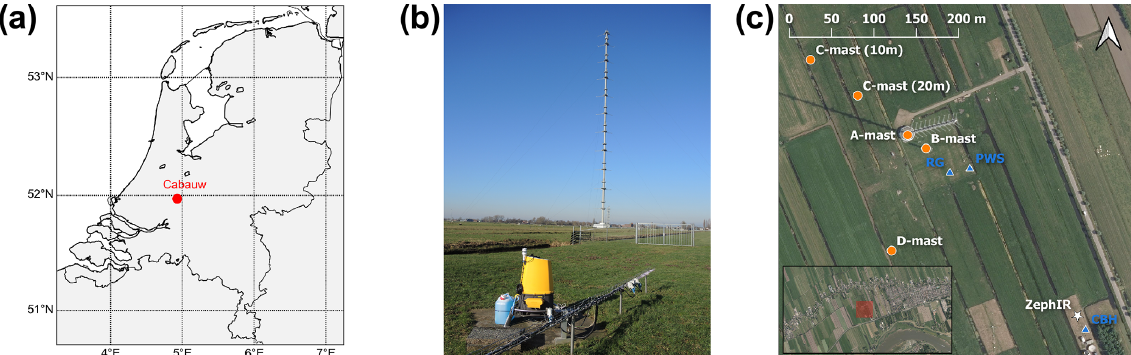
Figure 1. (a) Map of the Netherlands, indicating the location of measurement site near Cabauw (51.971 ◦ N, 4.927 ◦ E). (b) Photo of the ZephIR 300 wind lidar instrument, with the 213m tall A mast visible the background (view in NW direction). (c) Overview of the locations of the masts, the ZephIR wind lidar and other relevant instruments: rain gauge (RG), ceilometer (CBH) and present-weather sensor (PWS); the inset shows the area around the site (images from PDOK Landelijke Voorziening Beeldmateriaal, Luchtfoto 2019 Ortho 25cm